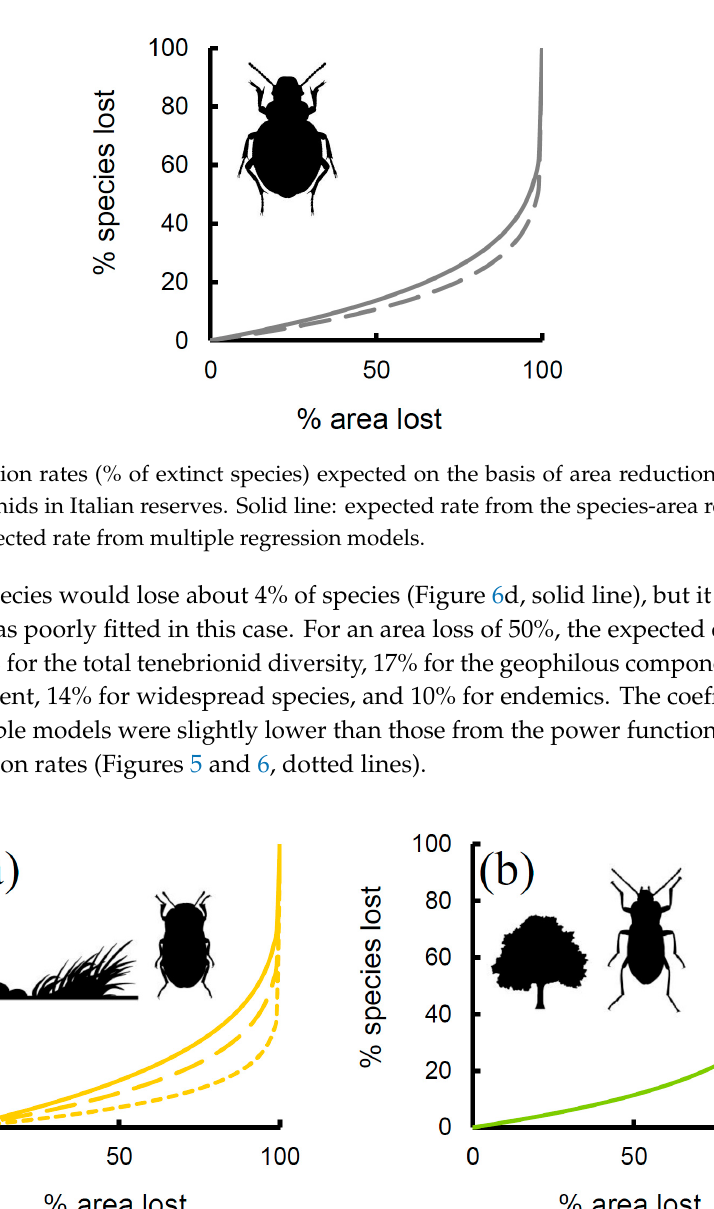
Figure 6. Extinction rates (% of extinct species) expected on the basis of area loss (% of area lost) for tenebrionids in Italian reserves. ( a ) geophilous species, ( b ) xylophilous species, ( c ) widespread species, ( d ) endemic species. Solid lines: expected rates from the species-area relationship. Dashed lines: expected rates from multiple regression models. In panel ( a ) the two dashed lines refer to calculations based on two exponents: 0.187 (upper) and 0.104 (lower). Lack of dashed lines in panels ( b , d ) is because the best-fit multiple models included only area. The endemic species would lose about 4% of species (Figure 6d, solid line), but it is important to note that the SAR was poorly fitted in this case. For an area loss of 50%, the expected extinction rates would be: about 11% for the total tenebrionid diversity, 17% for the geophilous component, 11% for the xylophilous component, 14% for widespread species, and 10% for endemics. The coefficients for area obtained from multiple models were slightly lower than those from the power function, thus reducing the expected extinction rates (Figures 5 and 6, dotted lines). 4. Discussion The z -values obtained for the tenebrionids of Italian reserves were between z = 0.15 and z = 0.26, thus being consistent with the range found for isolates (0.2–0.4), and very close to those found for habitat islands ( z = 0.22, on average) [62,63]. The highest c -value was found for the widespread species, and the lowest for the endemic species; namely, the number of species per area unit among the widespread species is about four times that of the endemic species. This is a reflection of the fact that widespread species are always more numerous than endemic species. The number of xylophilous species per area unit was slightly superior to that of geophilous ones. This can be explained by the lower dispersal ability of geophilous species (which belong mostly to the subfamily